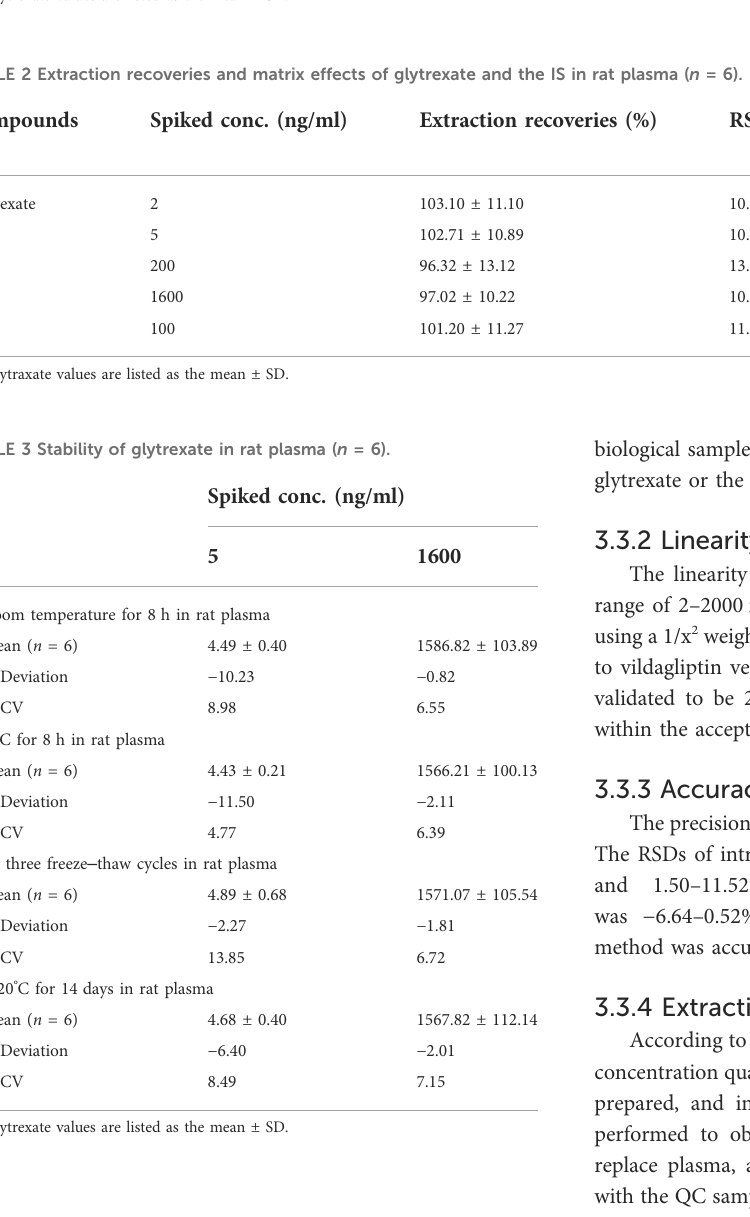
All glytrexate values are listed as the mean ± SD.